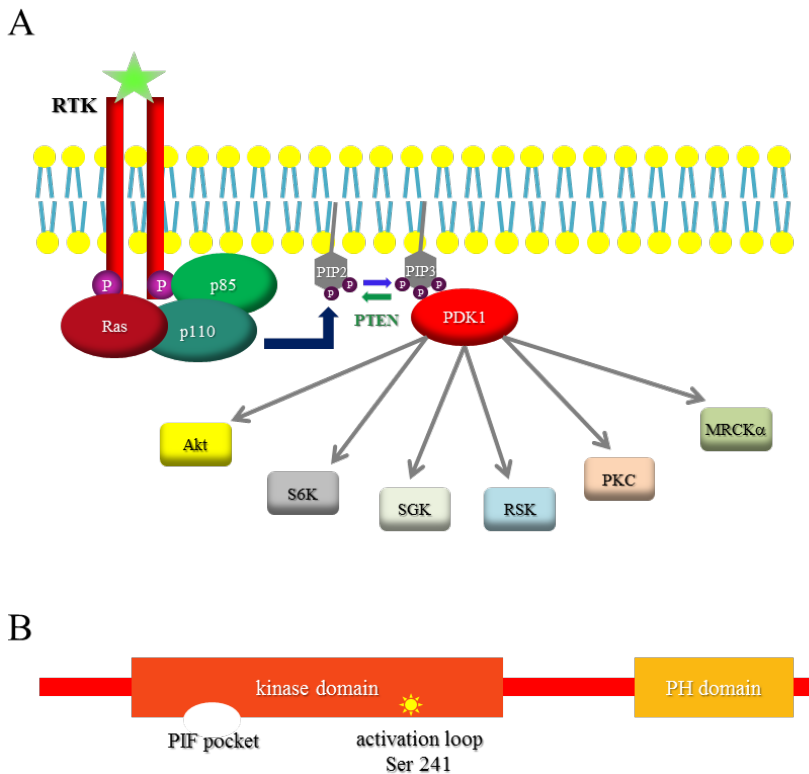
Figure 1. The phosphatidylinositol-3-kinase (PI3K)–3-phosphoinositide-dependent protein kinase-1 (PDK1) pathway. ( A ) Schematic representation of the pathway activated by PI3K through PDK1. Receptor-stimulated class I PI3Ks generate phosphatidylinositol (3,4,5) trisphosphate (PIP3), which bind directly to the pleckstrin homology domain of PDK1, which in turn activates a plethora of downstream targets, a selection of which is shown, with different mechanisms (kinase-dependent or -independent; pleckstrin homology (PH) domain-dependent, etc.); ( B ) PDK1 structure. PDK1 contains an N-terminal kinase domain and a C-terminal PH domain. Inside the kinase domain, there are two important sites: the PDK1 interacting fragment (PIF)-pocket and the activation loop; the